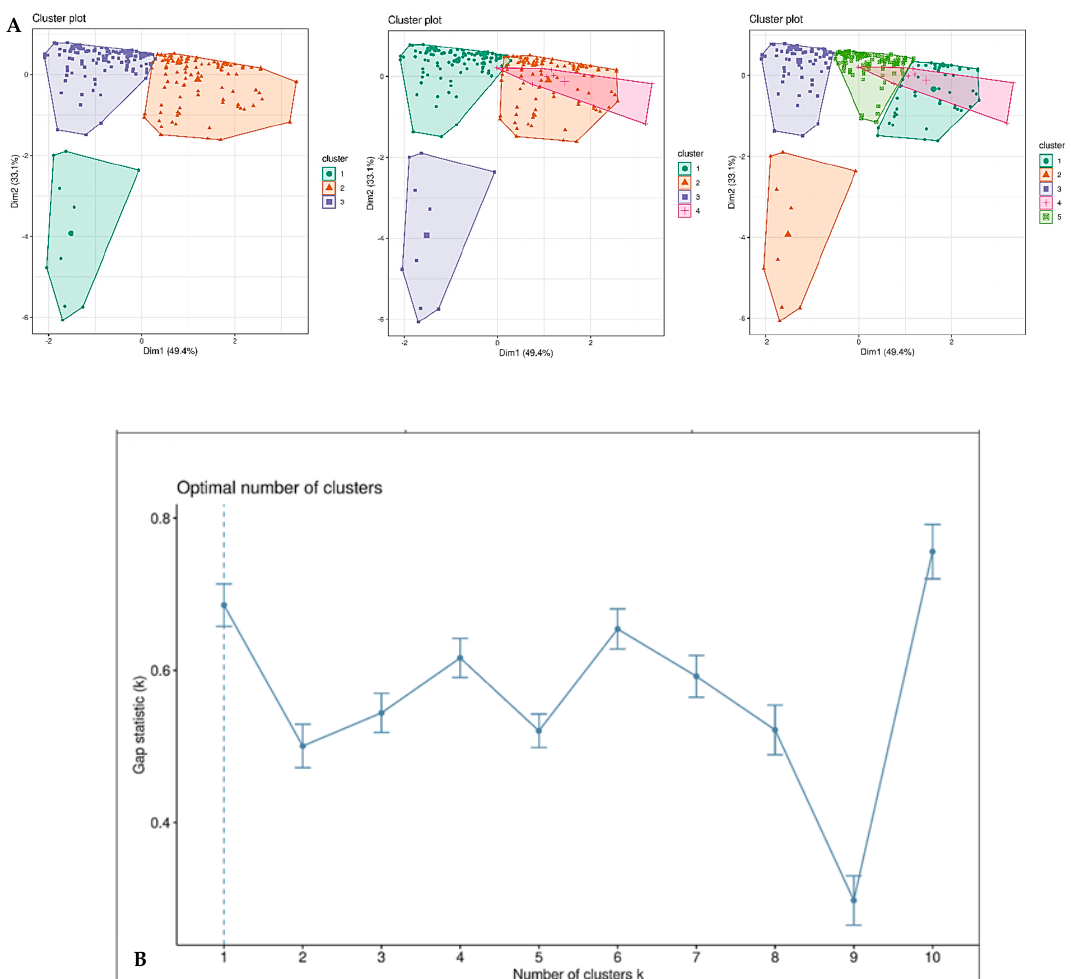
Figure 5. ( A ) Cluster analysis of the dataset provided and an assessment of how closely the different aspects of the datasets are matched. ( B ) Cluster gap analysis clarifies the optimal number of clusters and indicates that the optimal value is achieved when each location is placed in a separate cluster.